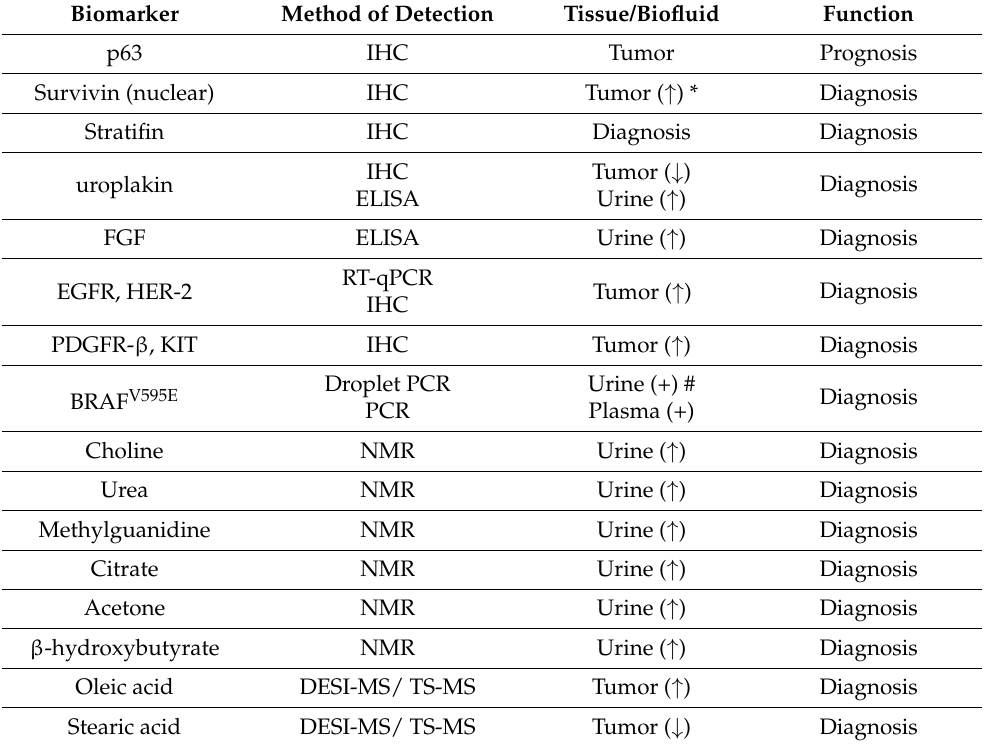
Table 2. Established and potential diagnostic and prognostic biomarkers for canine